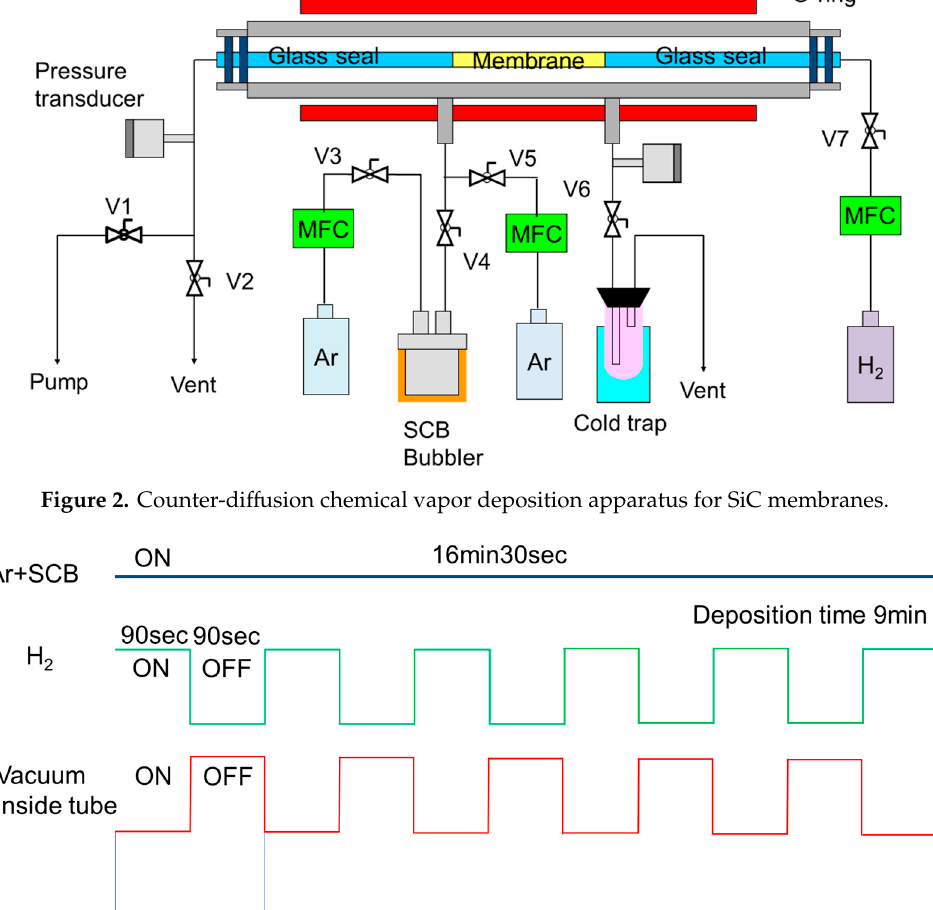
Figure 4. Pore size distribution of Ni- γ -Al 2 O 3 / α -Al 2 O 3 porous capillary. The cross-sectional backscattered electron image for SiC/Ni- γ -Al 2 O 3 / α -Al 2 O 3 is shown in Figure 5. The membrane was composed of two layers. The α -Al 2 O 3 capillary tube was uniformly coated with Ni- γ -Al 2 O 3 layer and the thickness of the Ni- γ -Al 2 O 3 layer was approximately 2.3 μ m. The contrast in the Ni- γ -Al 2 O 3 layer originated from the heating history.